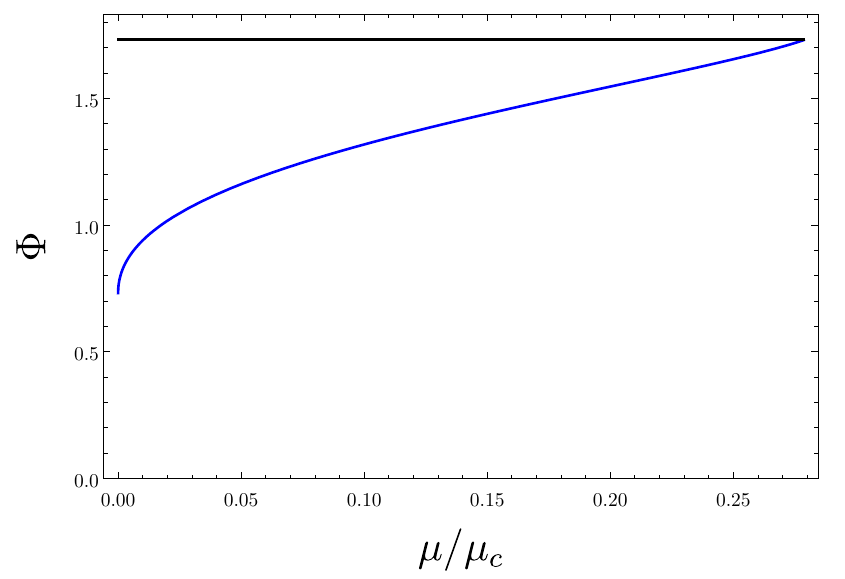
Figure 12 . Special values of potential in five dimensions . Here we show a plot of the value of potential at which the structure of the T r + profiles change from resembling the uncharged case − to exhibiting a closed curve. The black curve represents the value at which this occurs in Einstein gravity Φ = √ 3. Note that the limit between the two cases is discontinuous. The blue curve 280 = 79 L 4 / 1890, since after this point the theory does not admit large terminates at µ = 79 µ c / − black hole solutions.